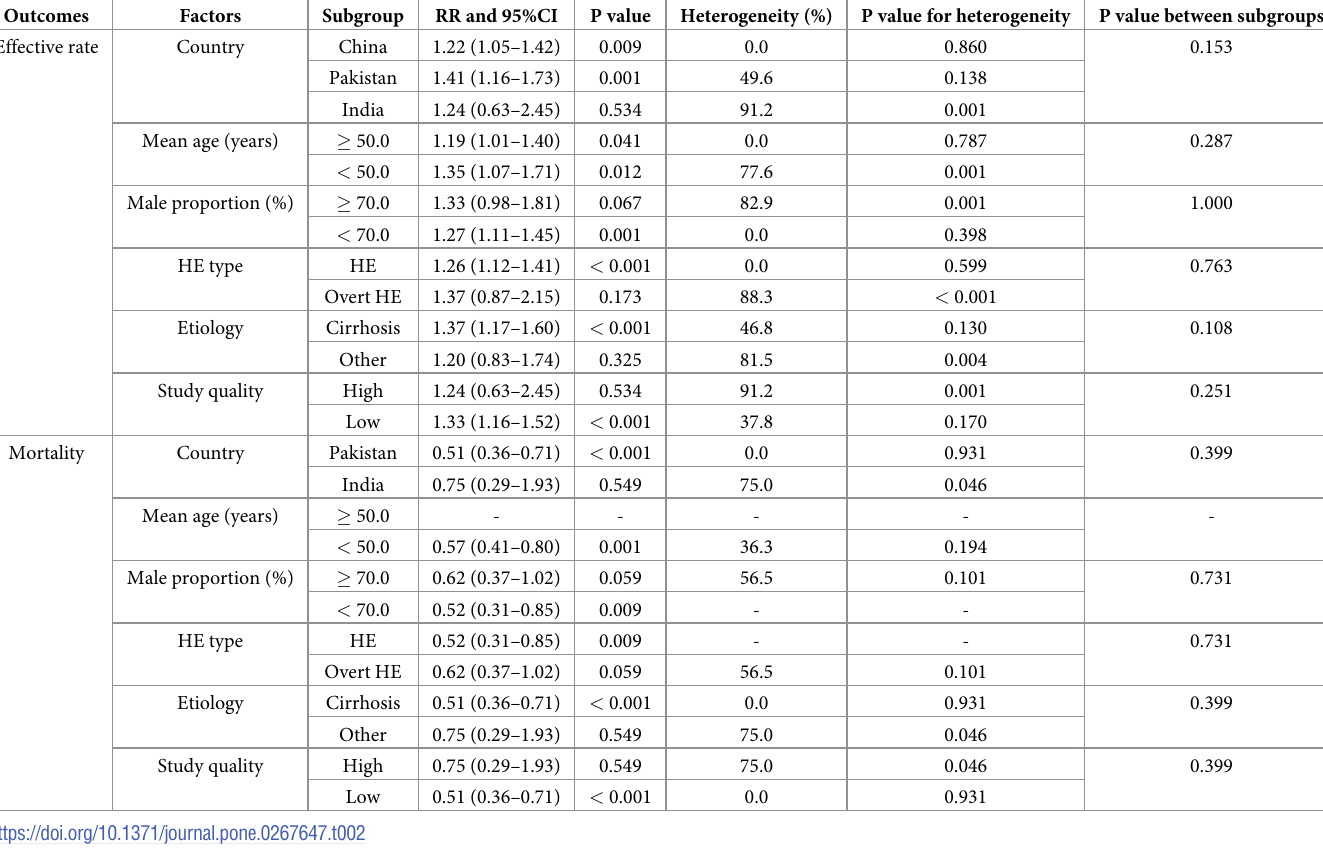
Table 2. Subgroup analyses for effective rate and mortality.